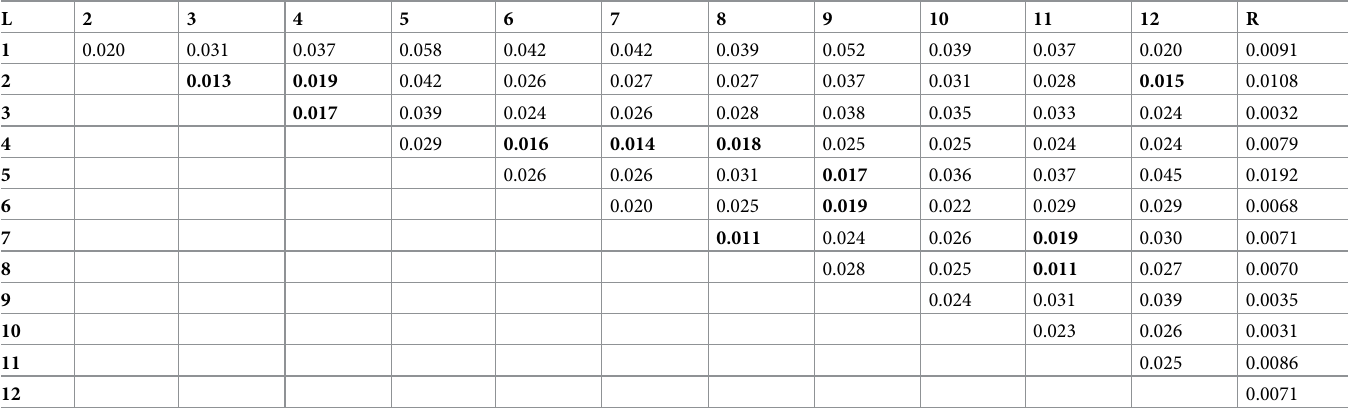
Table 1. The pairwise distances between the centers of the clusters ( L ) and their radiuses ( R ) on the 16 × 16 elastic map in Figs 4–6.